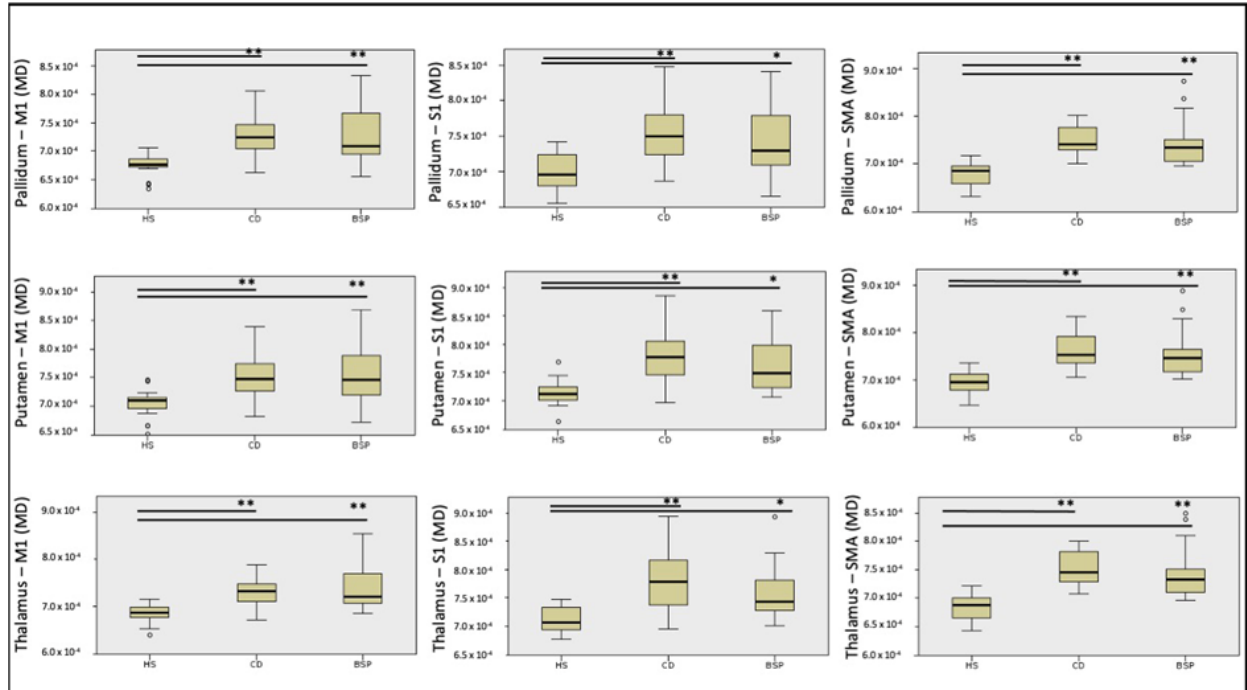
Figure 3. Differences in mean diffusivity (MD) of cortical-subcortical white matter tracts among subjects. HS: healthy subjects; CD: cervical dystonia; BSP: blepharospasm; M1: primary motor cortex head/face region; S1: primary sensory cortex head/upper limb region; SMA: supplementary motor